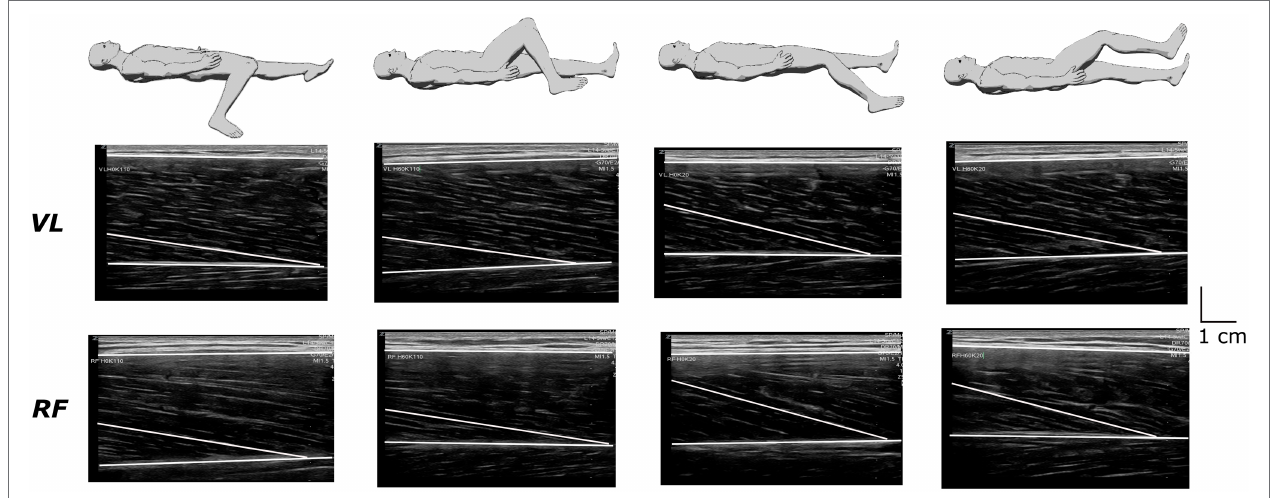
FIGURE 2 | Recordings of ultrasound images from the vastus lateralis (VL) and the rectus femoris (RF) muscles under the different positions in a representative